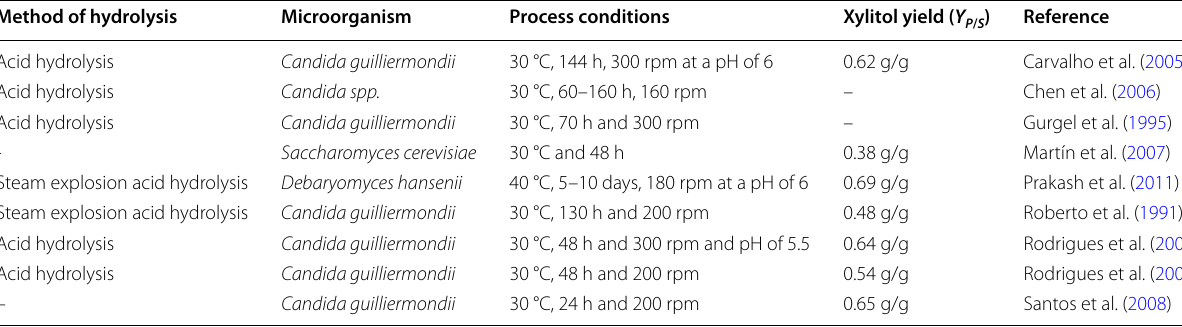
Table 5 Summary of xylitol production from SCB Method of